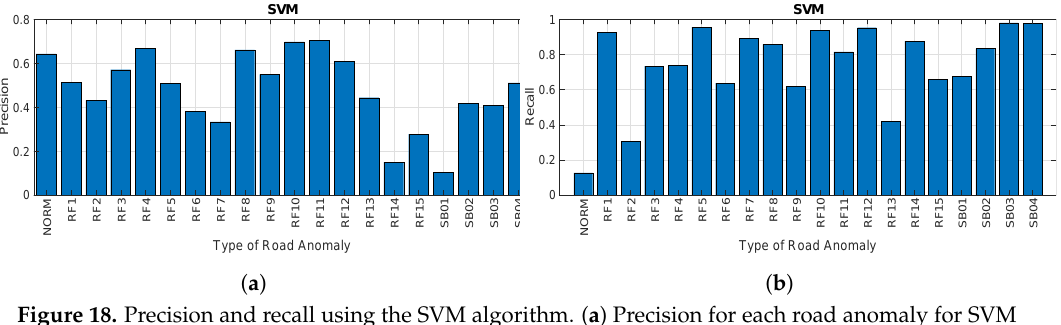
Figure 18. Precision and recall using the SVM algorithm. ( a ) Precision for each road anomaly for SVM (sampling rate of 50 Hz) and ( b ) recall for each road anomaly using SVM (sampling rate of 50 Hz).